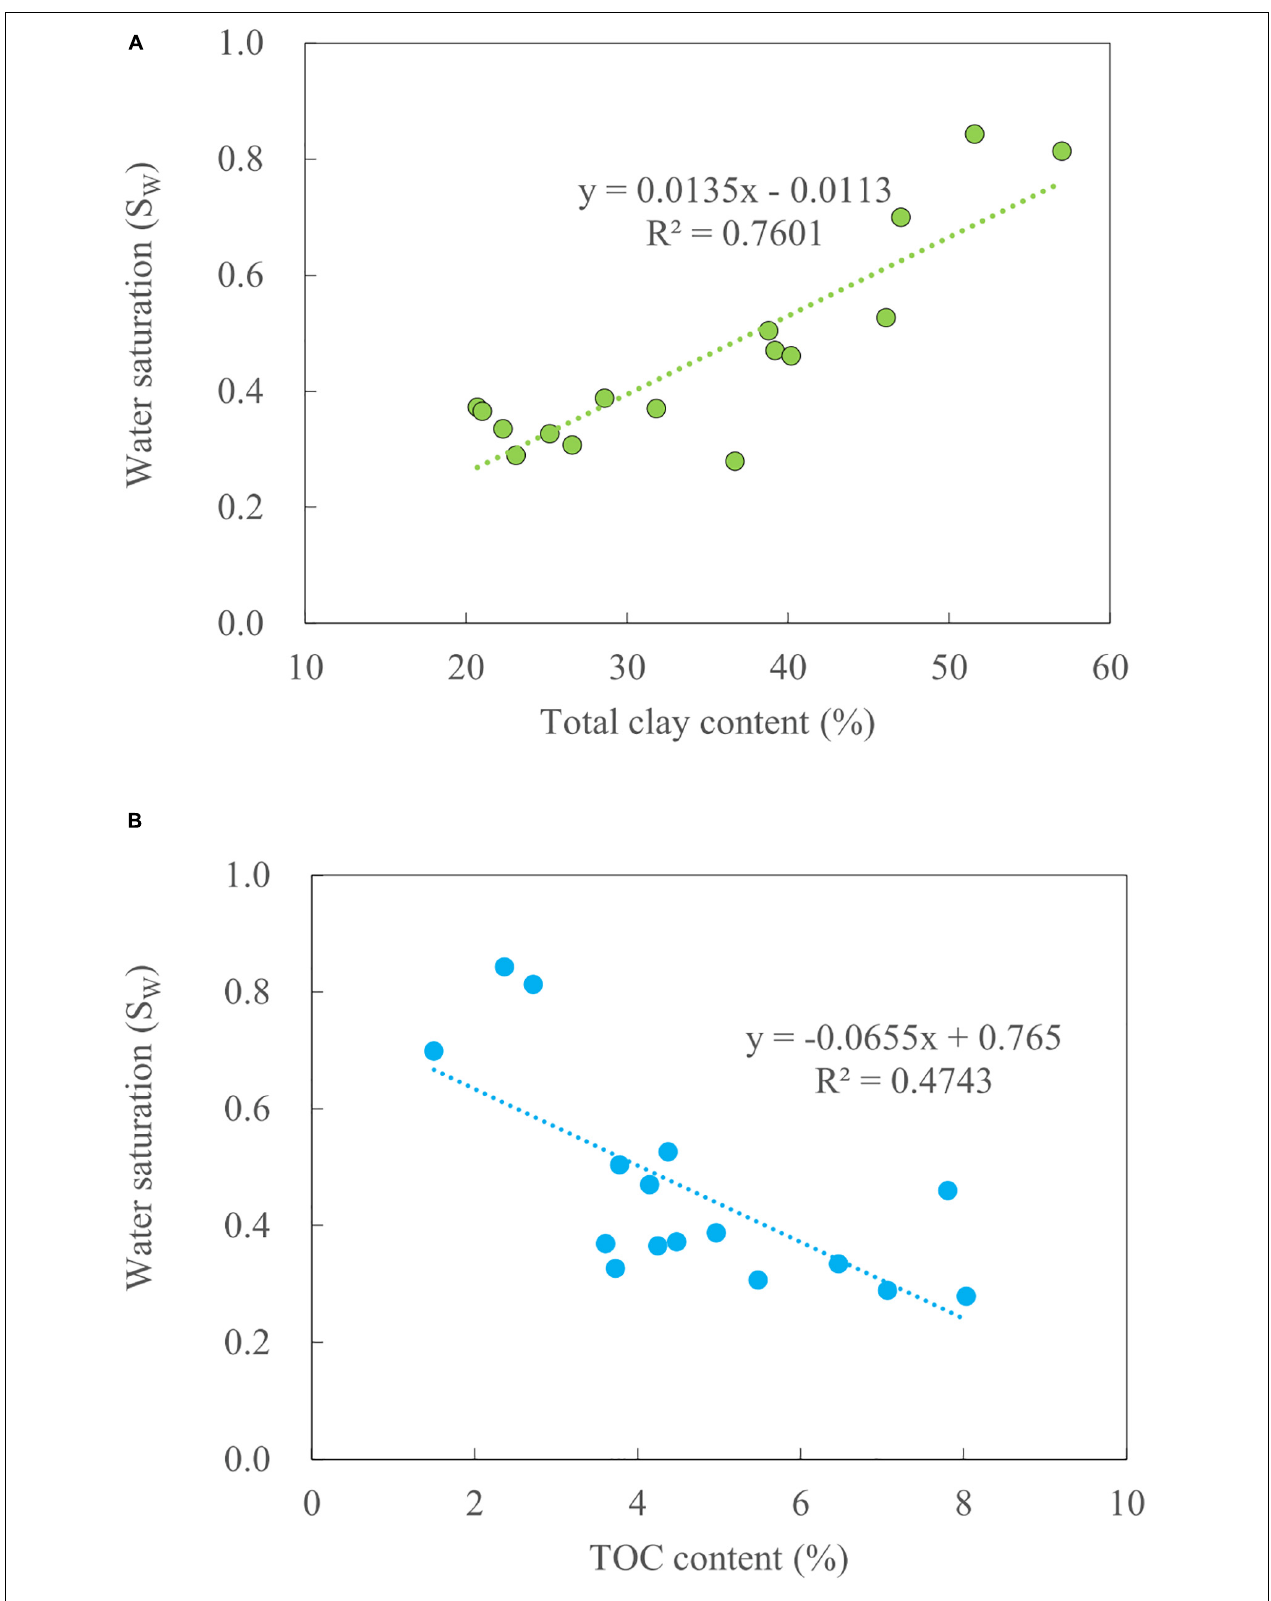
FIGURE 9 | Relationships of S W with total clay mineral (A) and TOC contents (B) . See details in text.